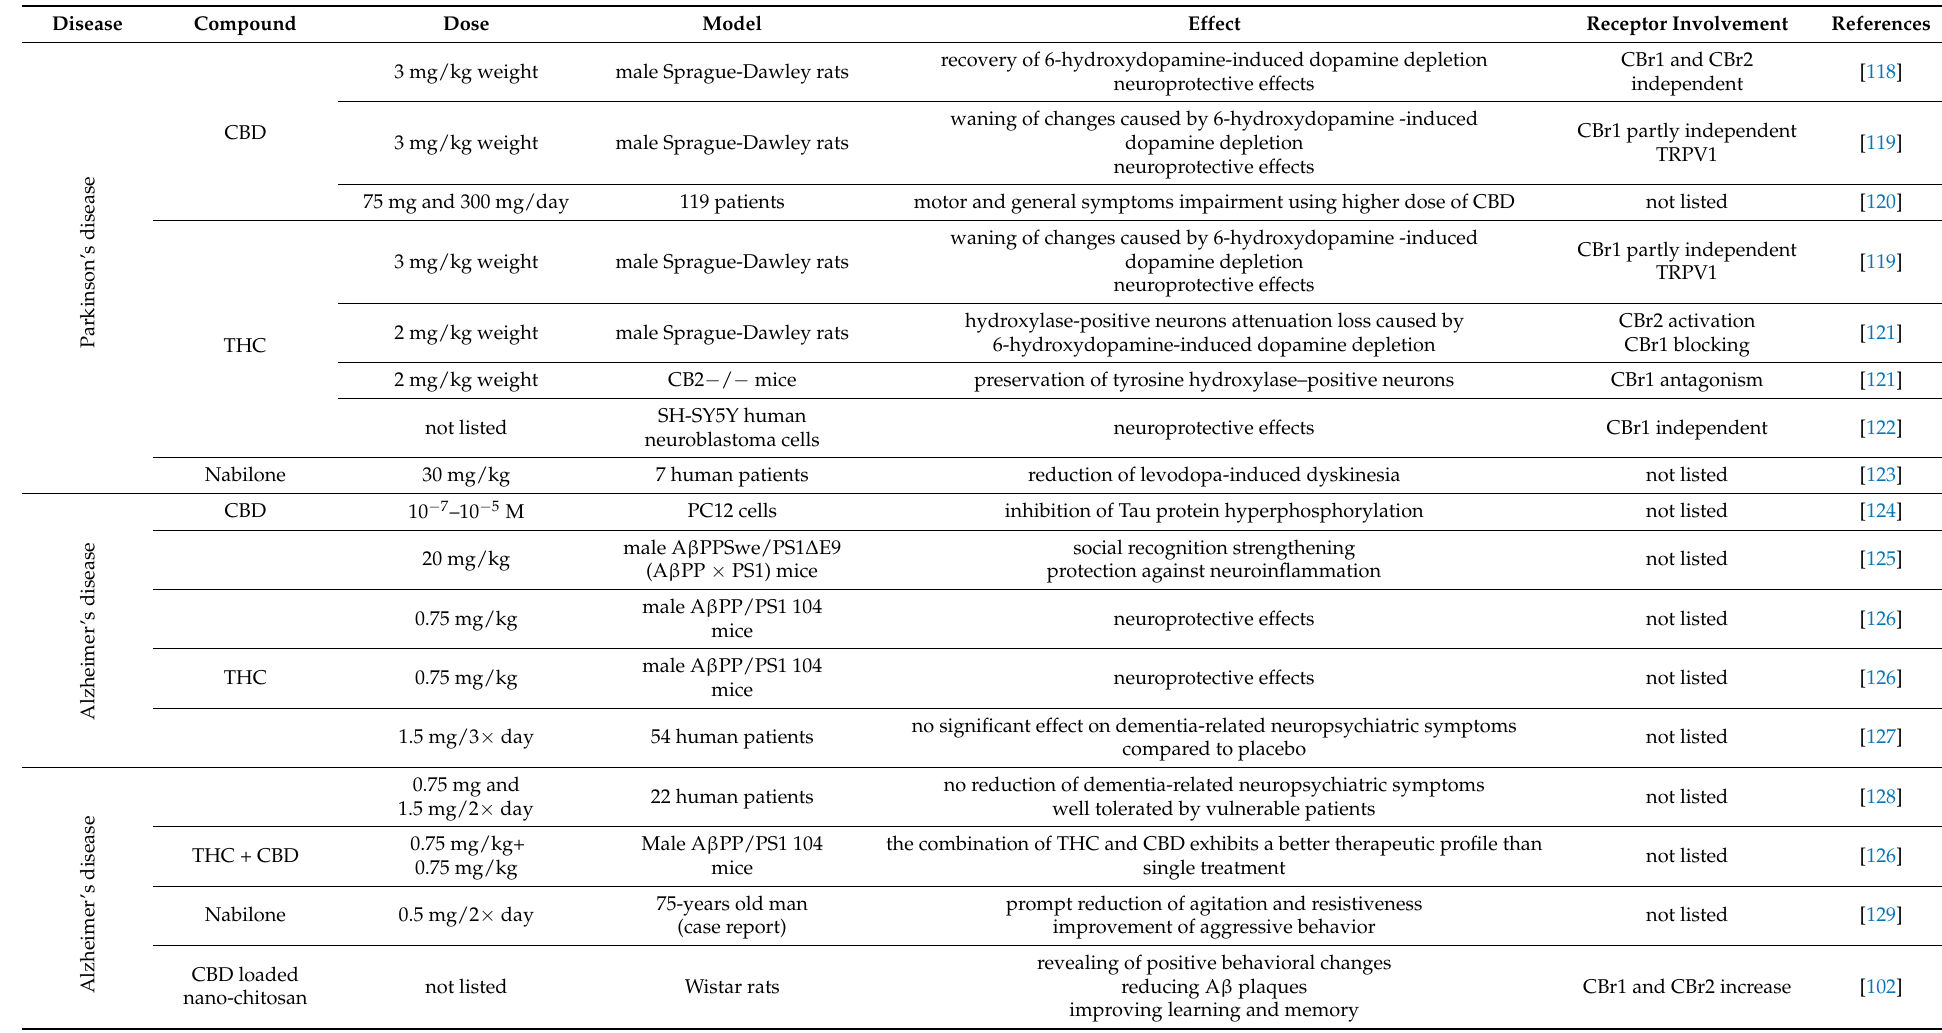
Table 2. Some cannabinoids-based treatments for selected neurological